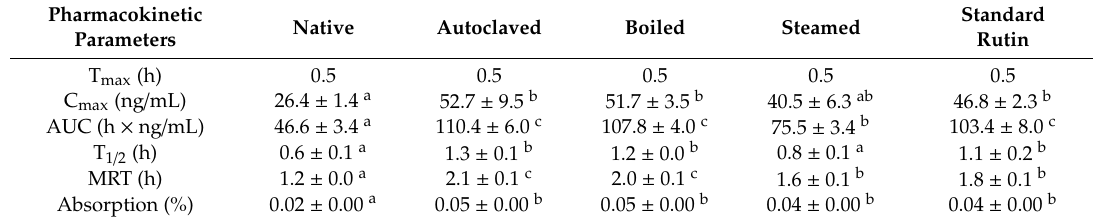
Table 2. Pharmacokinetic parameters and oral absorption of native, rutin-enriched TBFEs, and standard rutin after single-dose oral administrations in rats. Di ff erent lowercase letters (a, b, and c) indicate significant di ff erences among native, rutin-enriched (autoclaved, boiled, and steamed) TBFEs, and standard rutin ( p <